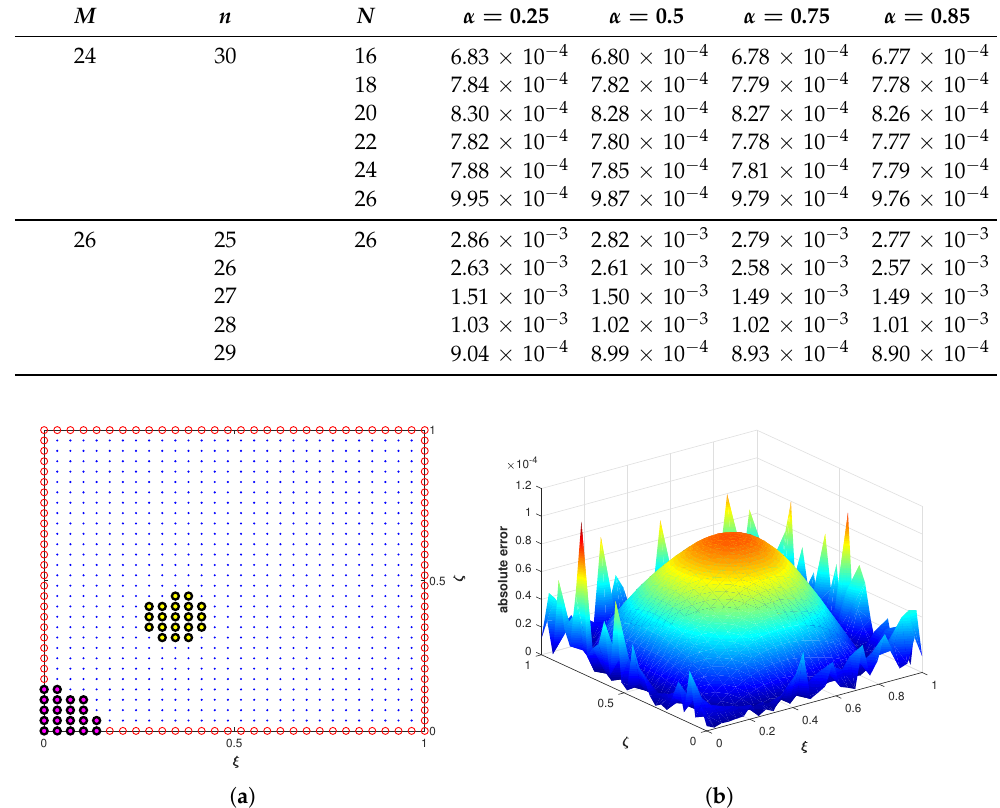
Table 5. The L ∞ error for different fractional orders α of problem 4.